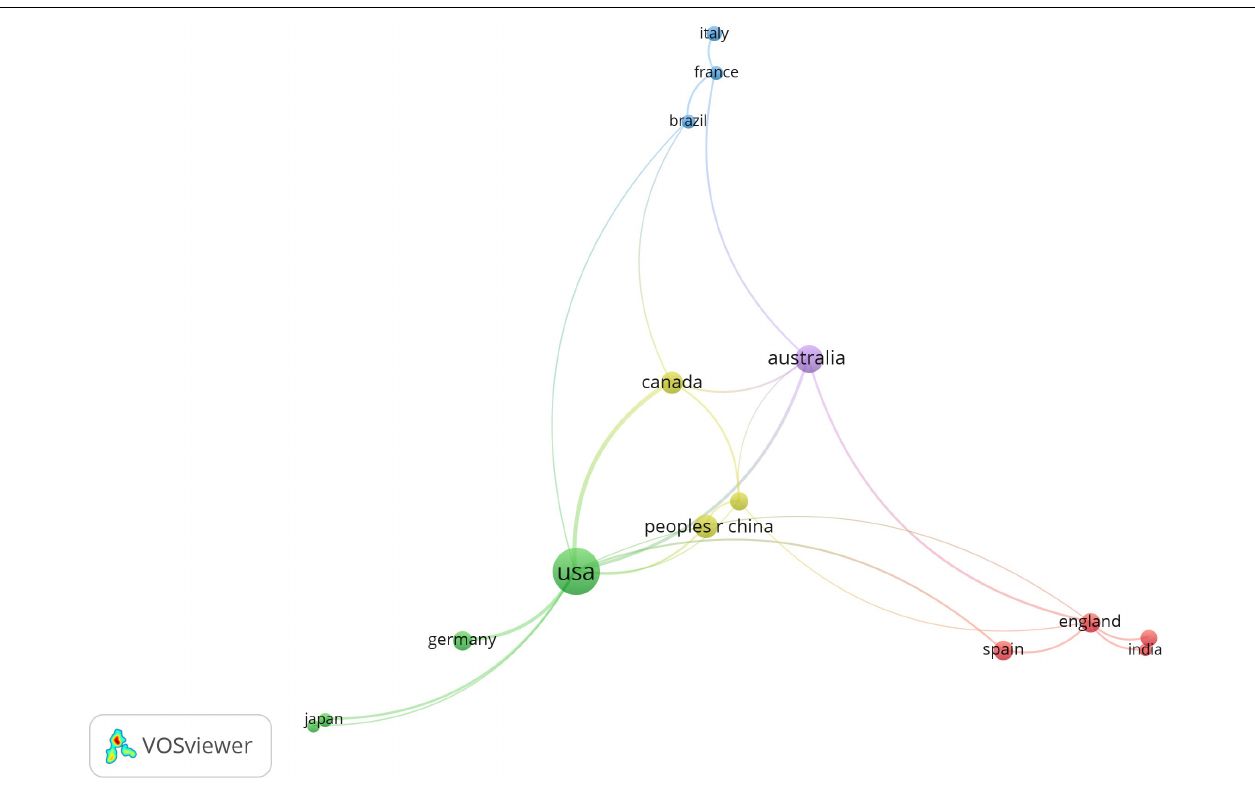
FIGURE 6 | Country distribution for the articles.